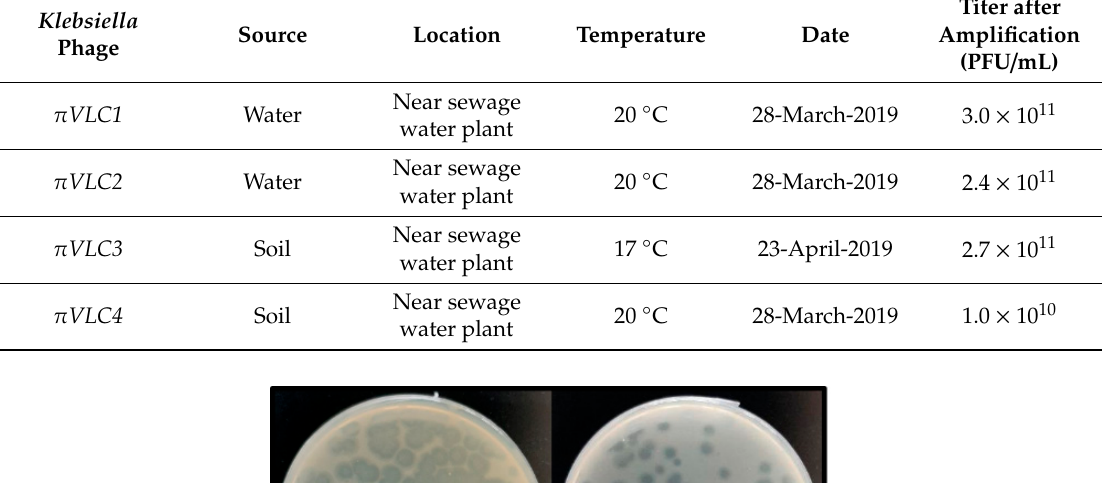
Table 1. Environmental conditions and sampling points. PFU: plaque-forming units.